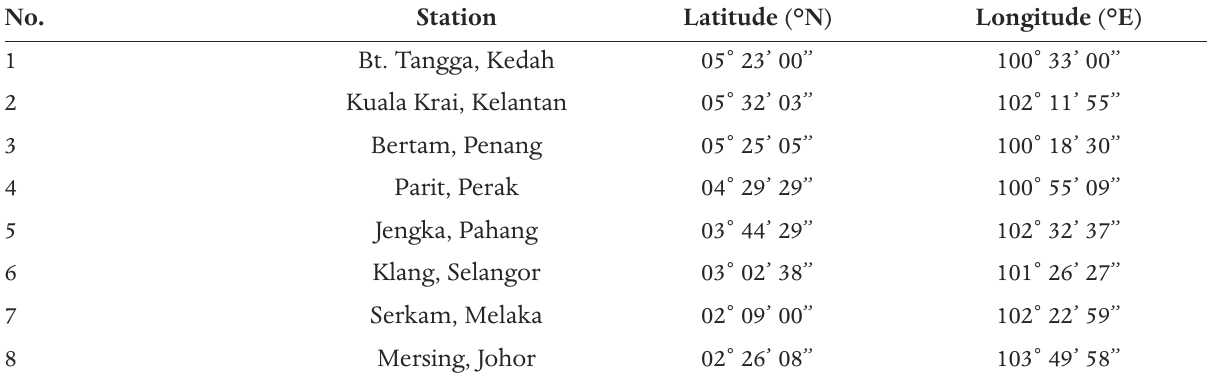
Table 2. Location of SAFIR 3000 sensors over the Peninsular